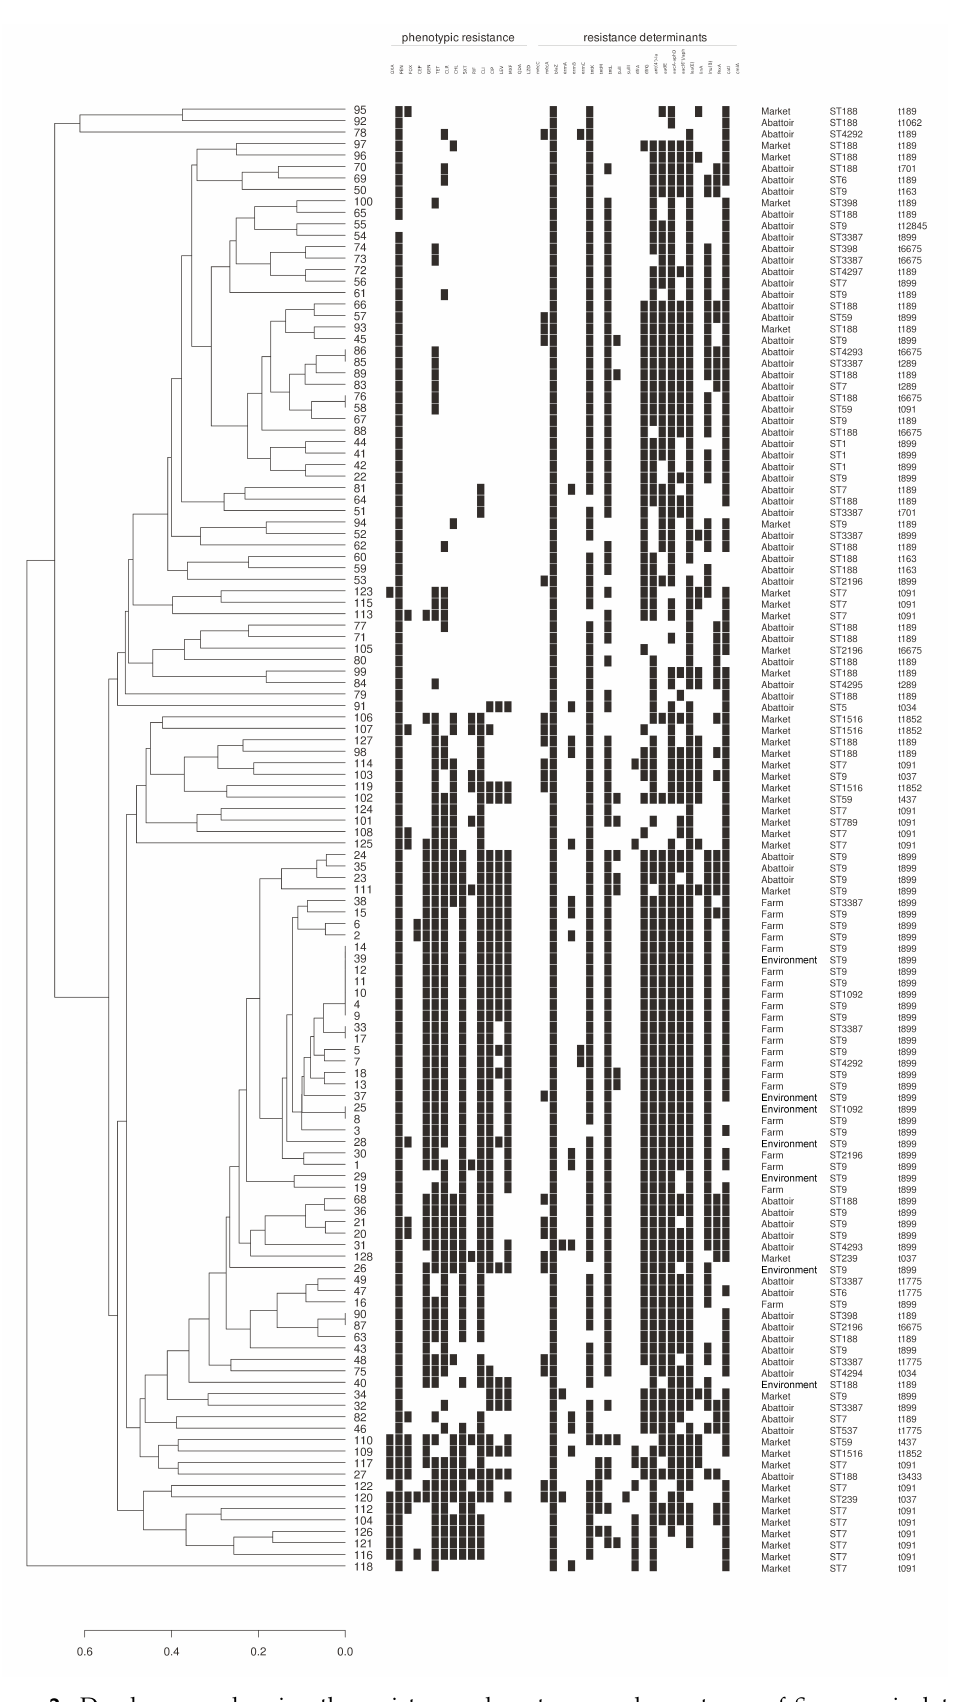
Figure 2. Dendrogram showing the resistance phenotypes and genotypes of S. aureus isolated from the pork production. The dendrogram was established based on the presence and absence of